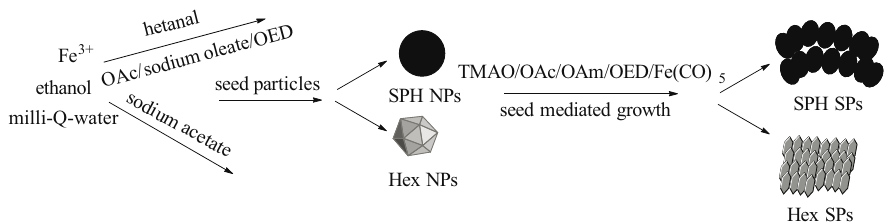
Figure 2: Flow diagram of solvent planting process [ 26